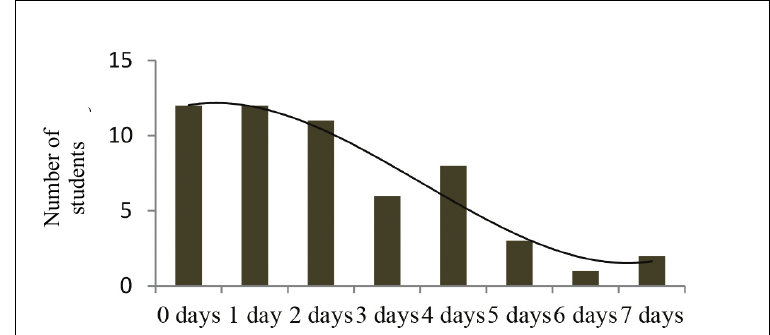
Figure 2. Frequency of doing the second men - tioned sport on a weekly basis